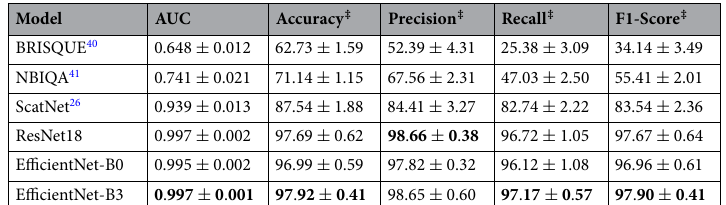
‡ Values recorded at operating point with